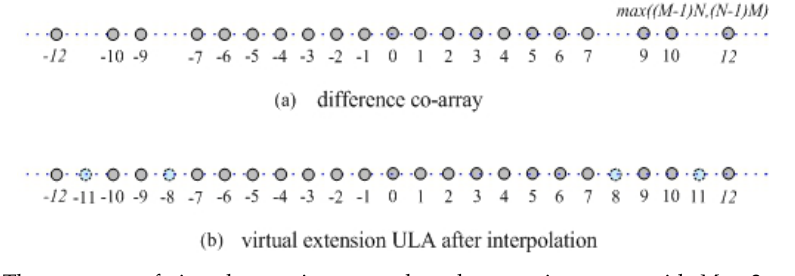
Figure 3. The structure of virtual extension arrays based on coprime array with M = 3 and N =